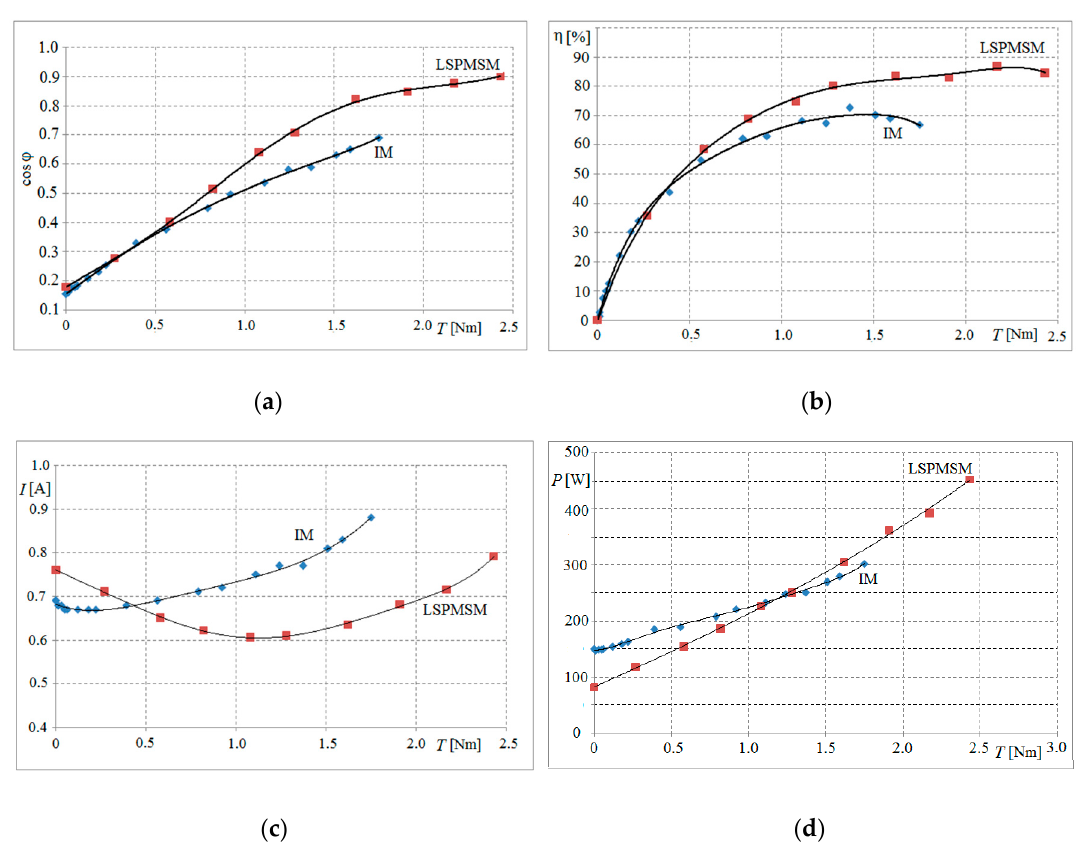
Figure 7. Comparison of functional parameters for LSPMSM and IM: ( a ) power factor; ( b ) efficiency; ( c ) phase current, ( d ) electric power.